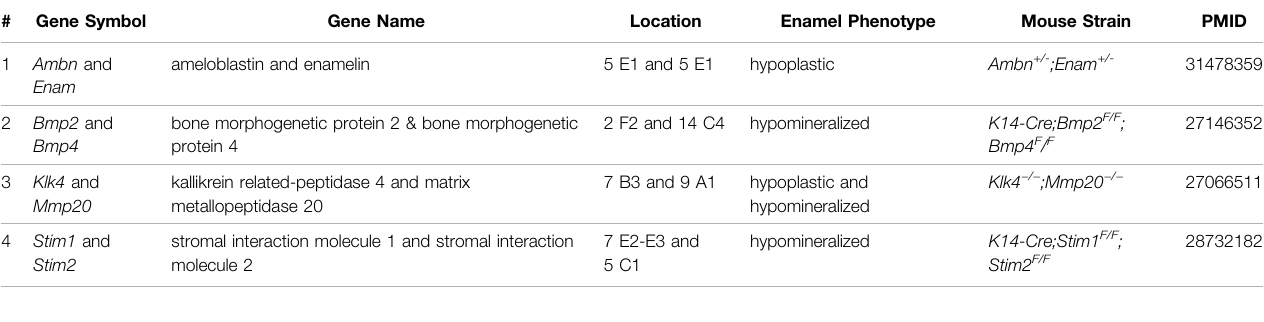
TABLE 2 | Compound mutant mouse models with enamel defects.